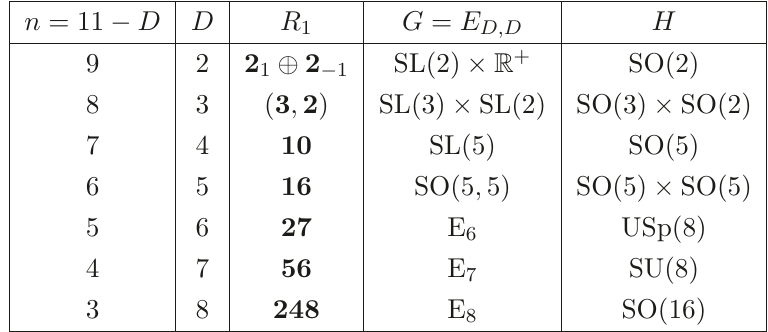
Table 1 . Generalised diffeomorphism groups and coordinate representations for